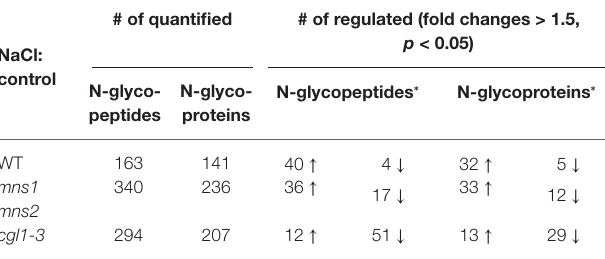
TABLE 1 | Statistical analysis of differentially abundant N-glycopeptides and N-glycoproteins in response to salt